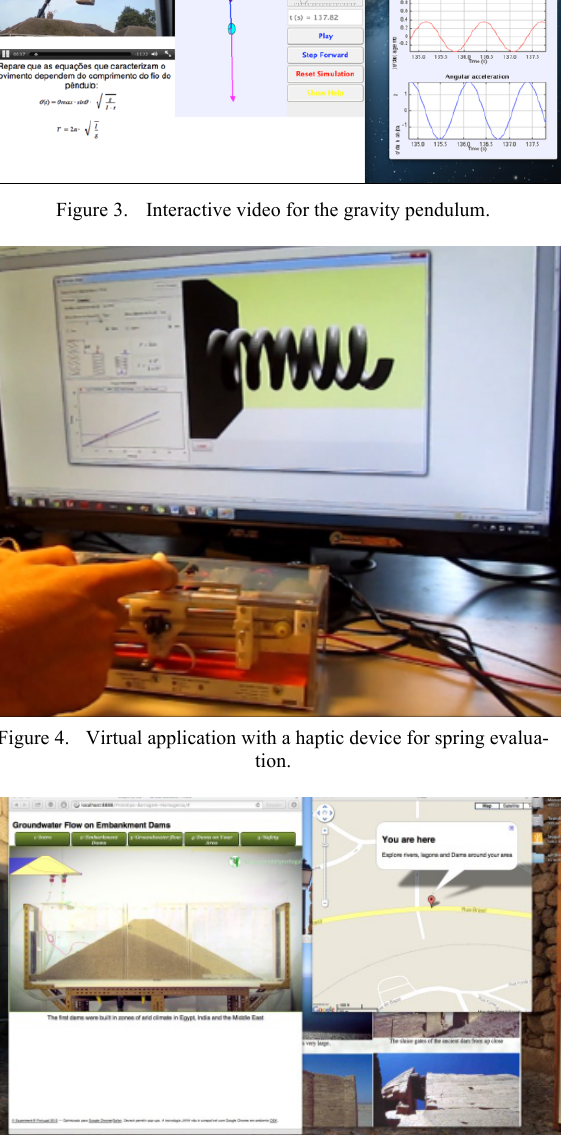
Figure 5. Interactive video for seepage phenomena.